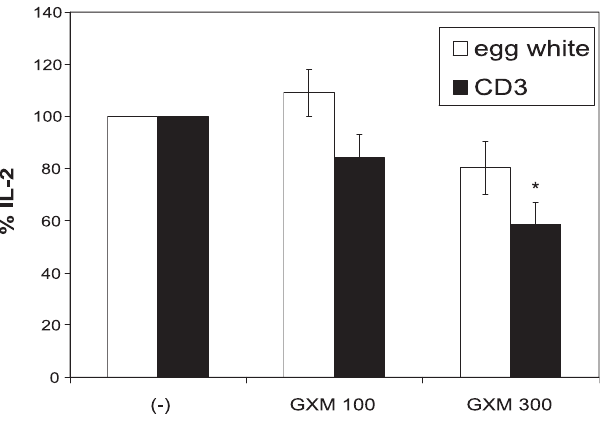
Figure 6. Effect of GXM on IL-2 Production Purified CD4 þ T cells from OT-II mice were activated with anti-CD3 e antibody or BMDCs plus egg white in the presence or absence of GXM (100 or 300 l g/ml) for 48 h. IL-2 levels were determined by ELISA or bioassay. Data are expressed as the percent of IL-2 compared with stimuli alone ( (cid:1) ) 6 SEM of two to four independent experiments done in triplicate. The mean IL-2 (pg/ml by ELISA) for egg white and anti-CD3 were 210 and 320, respectively. The mean IL-2 (U/ml by bioassay) for egg white was 0.65. * p ,